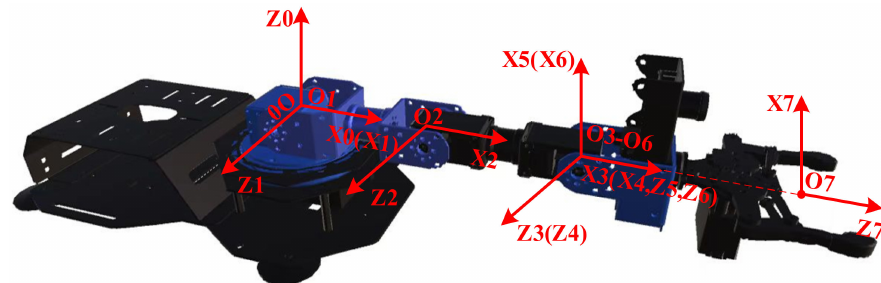
Figure 5. Manipulator coordinate